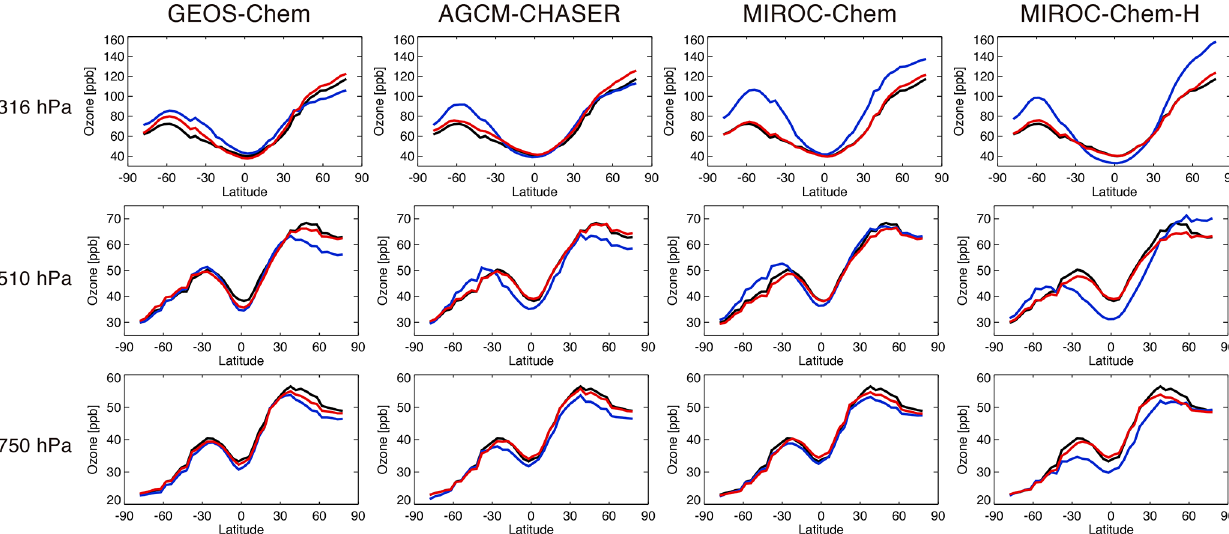
Figure 4. Comparisons of latitudinal distributions of annual and zonal mean ozone concentrations between the TES measurements (black line), control runs (blue line), and data assimilation analyses (red line) at 316hPa (upper panels), 510hPa (middle panels), and 750hPa (lower panels) in 2007 for the four systems.